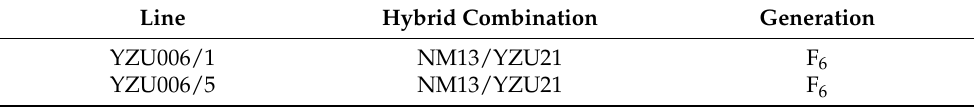
Table 1. The hybrid combination and generation information of new